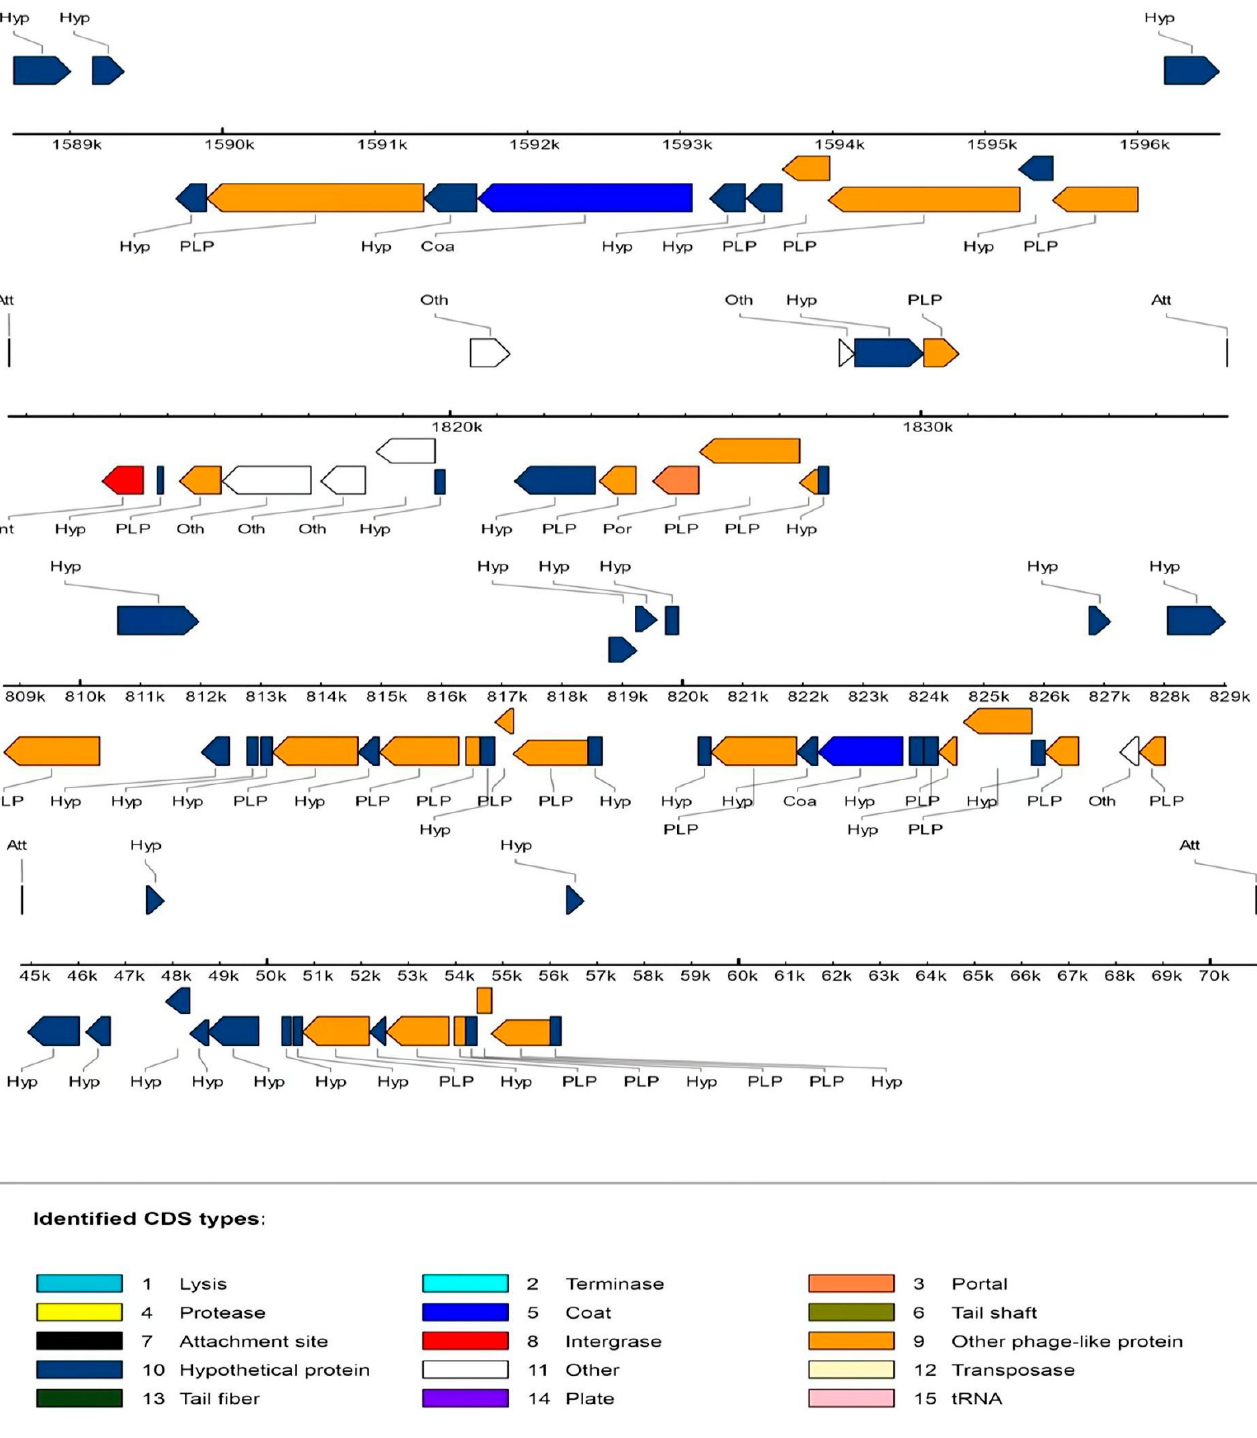
Figure 6. Schematic diagram of the FP17 prophage organization.